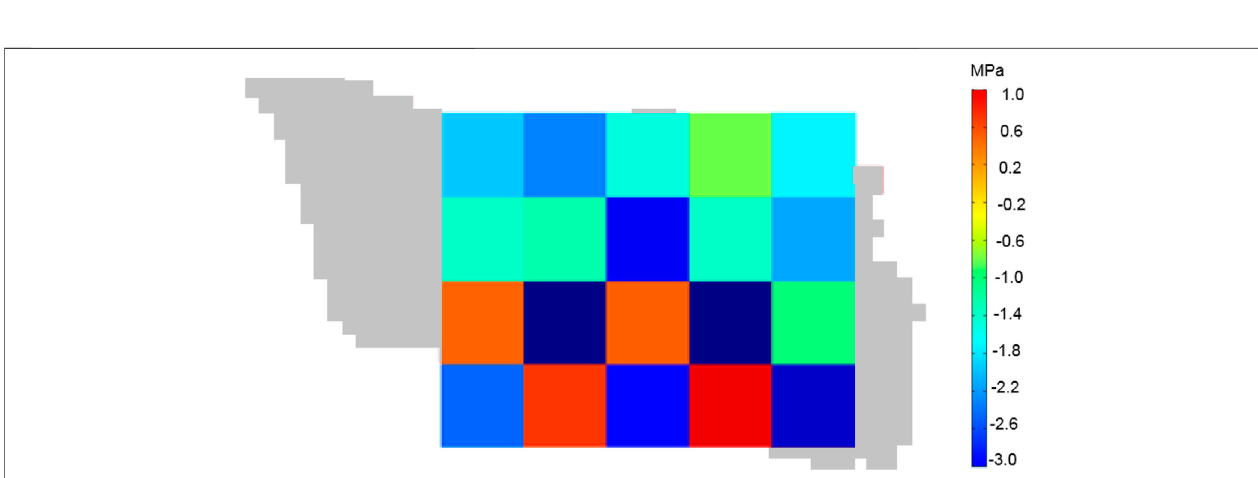
FIGURE 12 | Comparison of strata pressure change from November 2017 to April 2018 from surface displacement inversion.